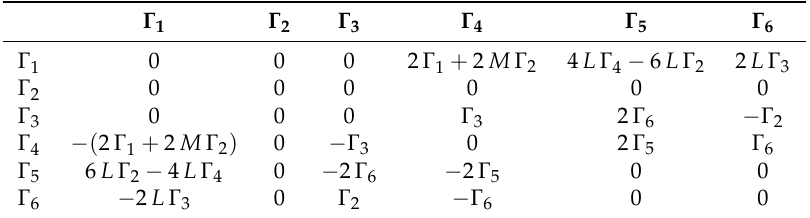
Table 2. Commutator table for the basis operators Γ i of the tumor